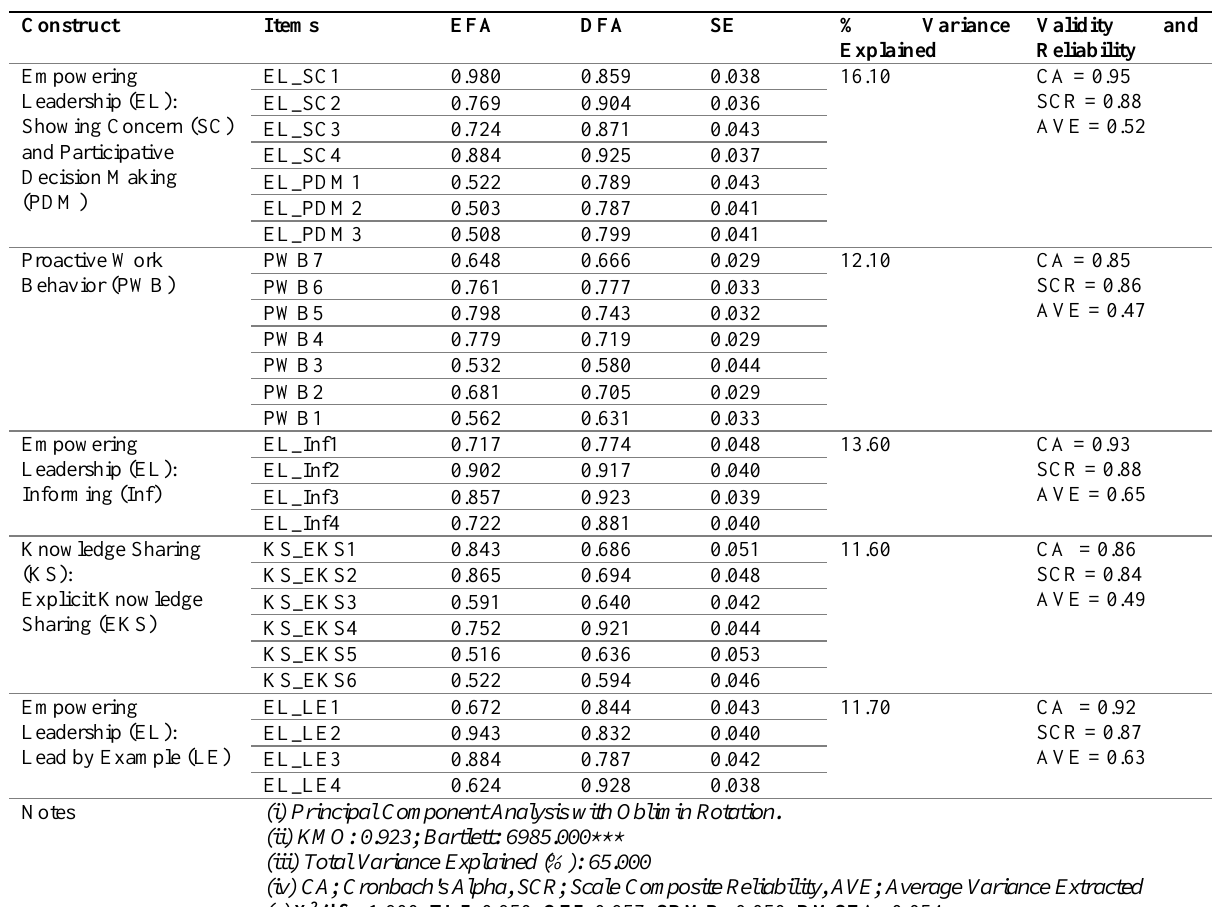
Table 1: Factor Analysis and Reliability Analysis